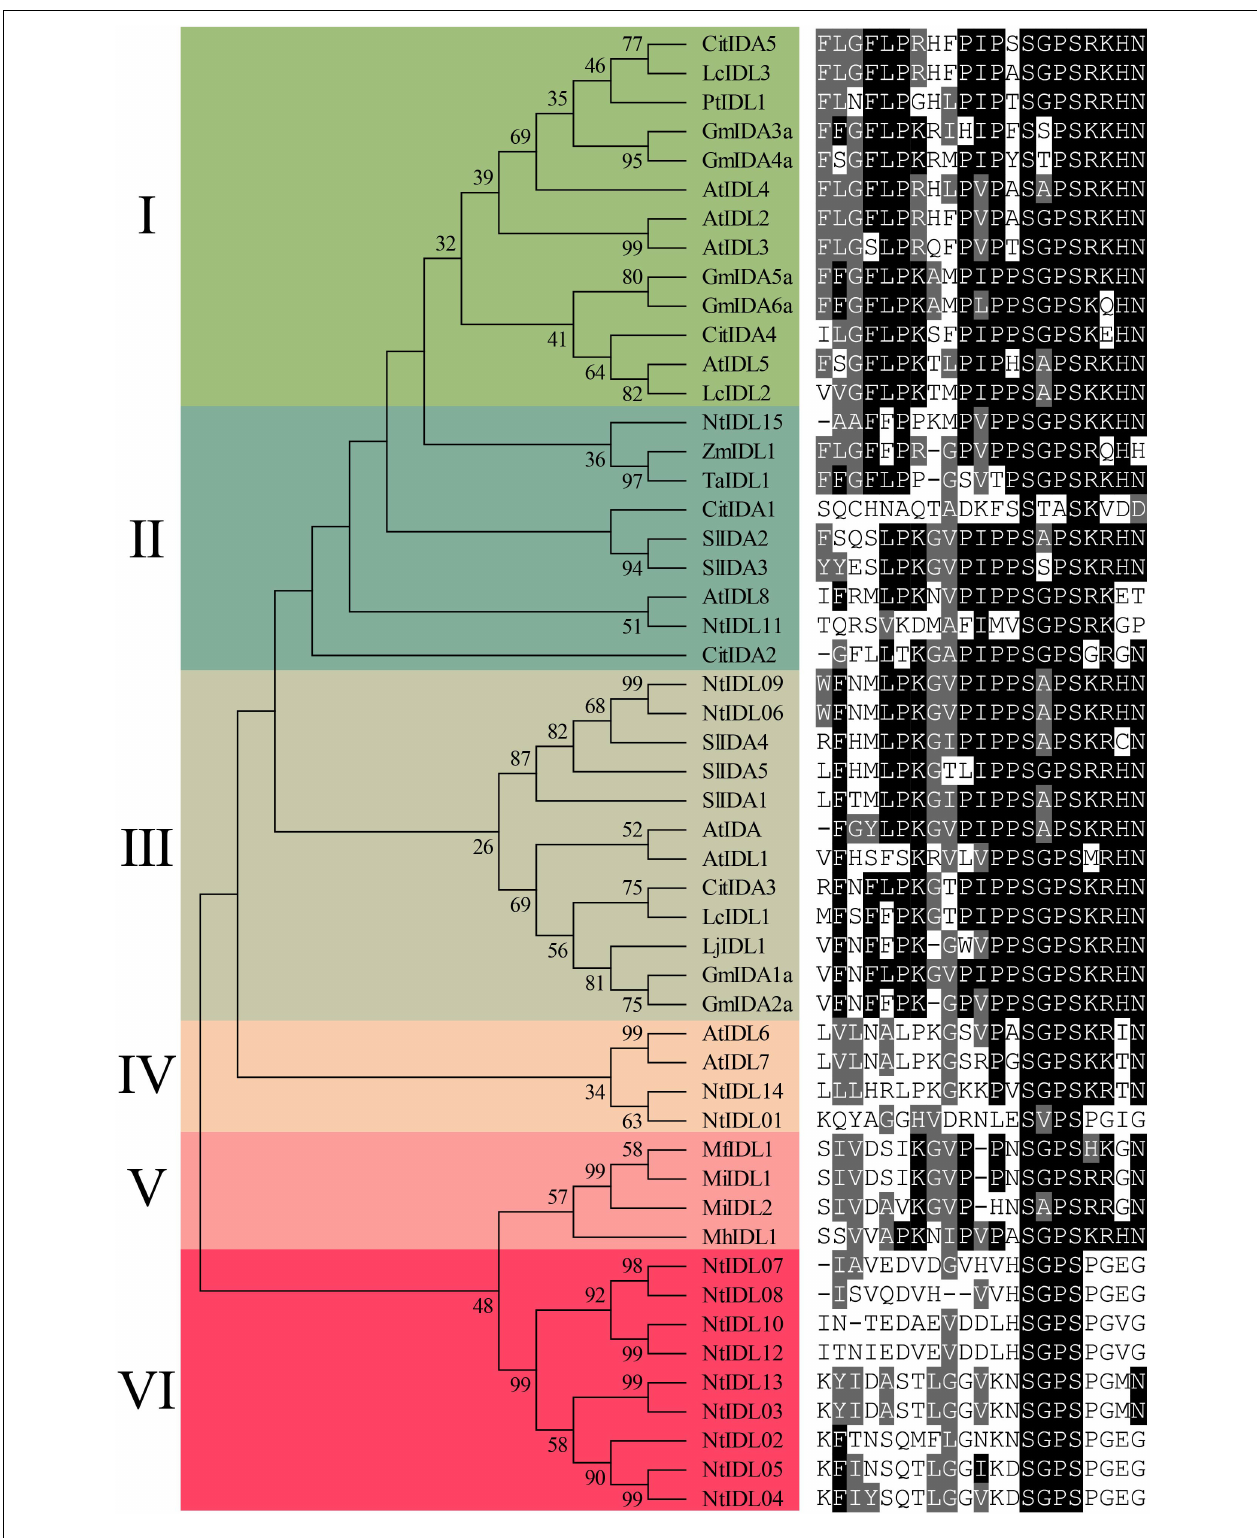
FIGURE 1 | Phylogenetic analysis of NtIDL family members. Citrus (Cit), Litchi chinensis (Lc), Populus (Pt), Glycine max (Gm), Arabidopsis thaliana (At), Solanum lycopersicum (Sl), Nicotiana tabacum (Nt), Zea mays (Zm), Triticum aestivum (Ta), southern root-knot nematode ( Meloidogyne incognita , Mi), northern root-knot nematode ( Meloidogyne. hapla , Mh), and peach root-knot nematode ( Meloidogyne. floridensis , Mf). On the right is the conservative EPIP sequences alignment.